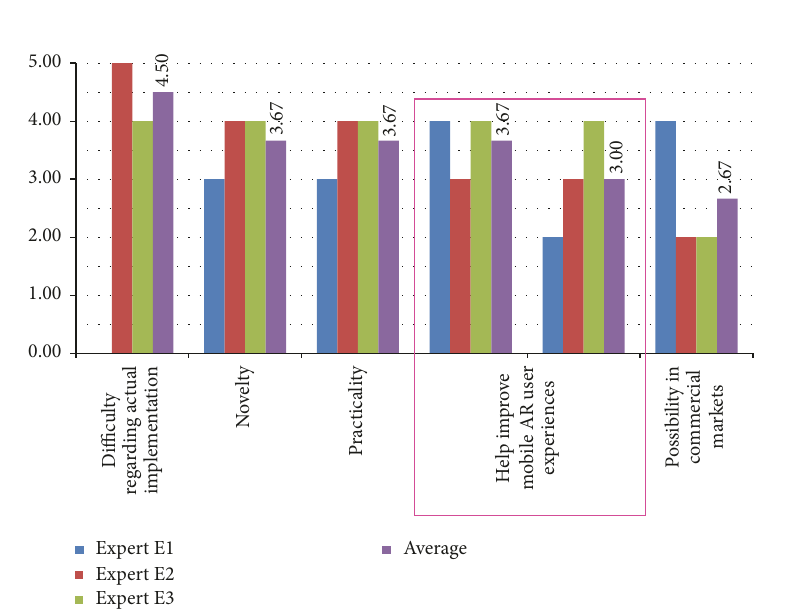
Figure 8: Conclusion of the semiquantitative results in Table 5. The five attributes are sorted and visualized by their average rating values from the highest (leftmost) to the lowest